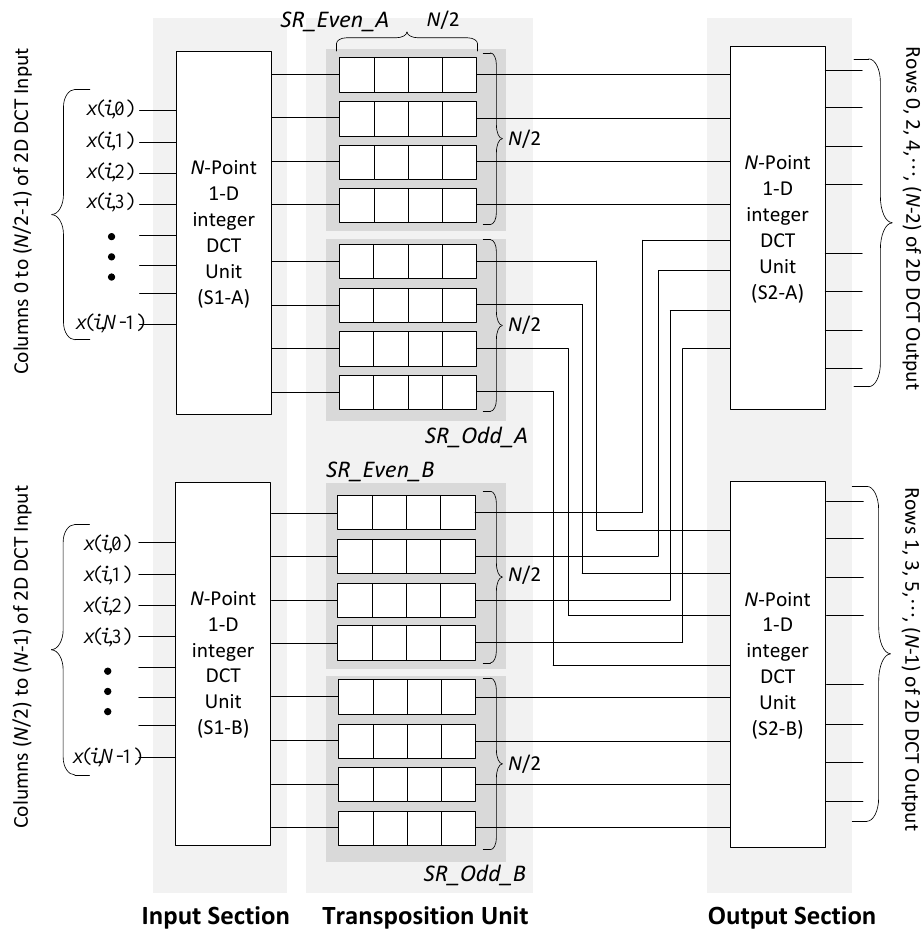
Figure 5. Proposed architecture for the 2D integer DCT of size N × N